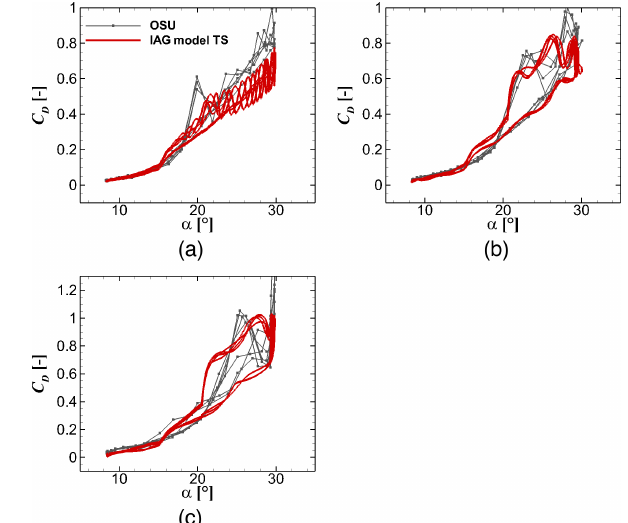
Figure 16. Drag reconstruction by the IAG model in comparison with the measurement data (Ramsay et al., 1996) for (cid:49)t = T/ 1440 using the actual angle of attack in the experimental campaign at various k values. From (a) to (c) : k = 0 . 036, k = 0 . 073 and k =